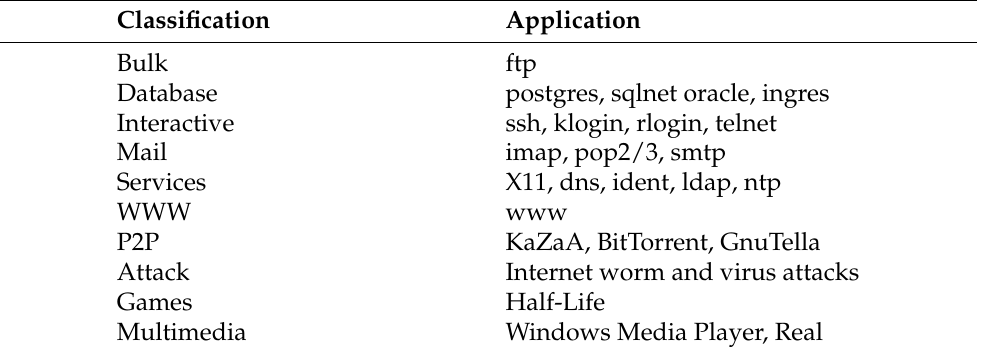
Table 1. Applications for traffic